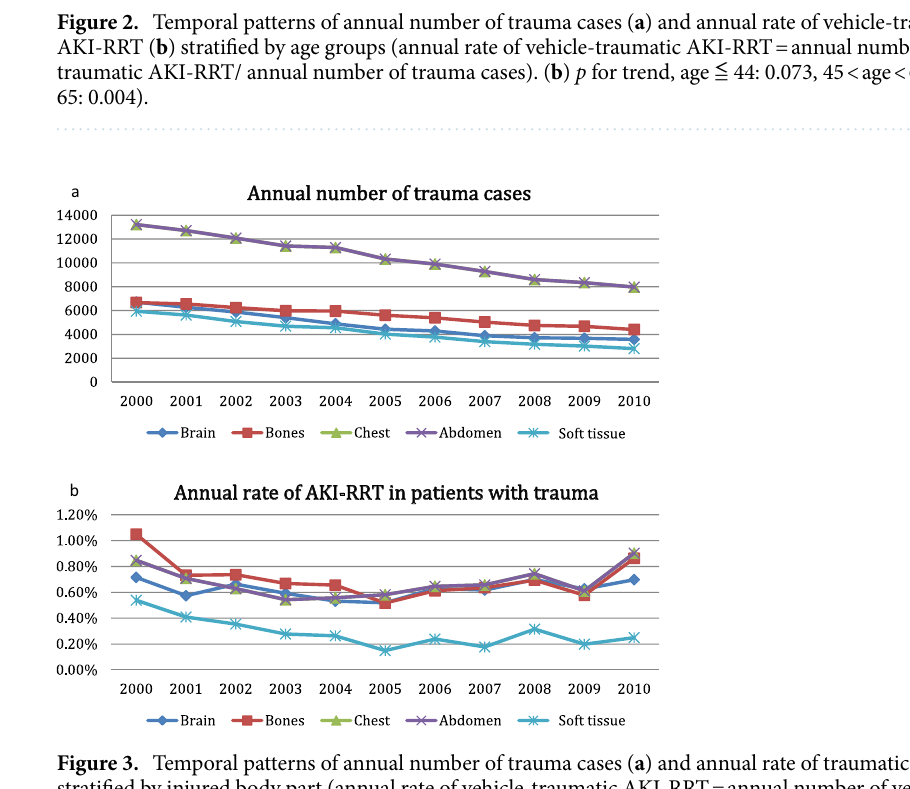
(10.6% vs. 13.4%, p = 0.832) (Table 1).